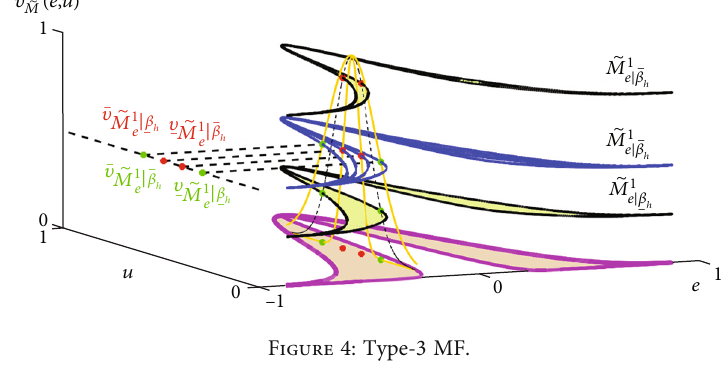
Figure 4: Type-3